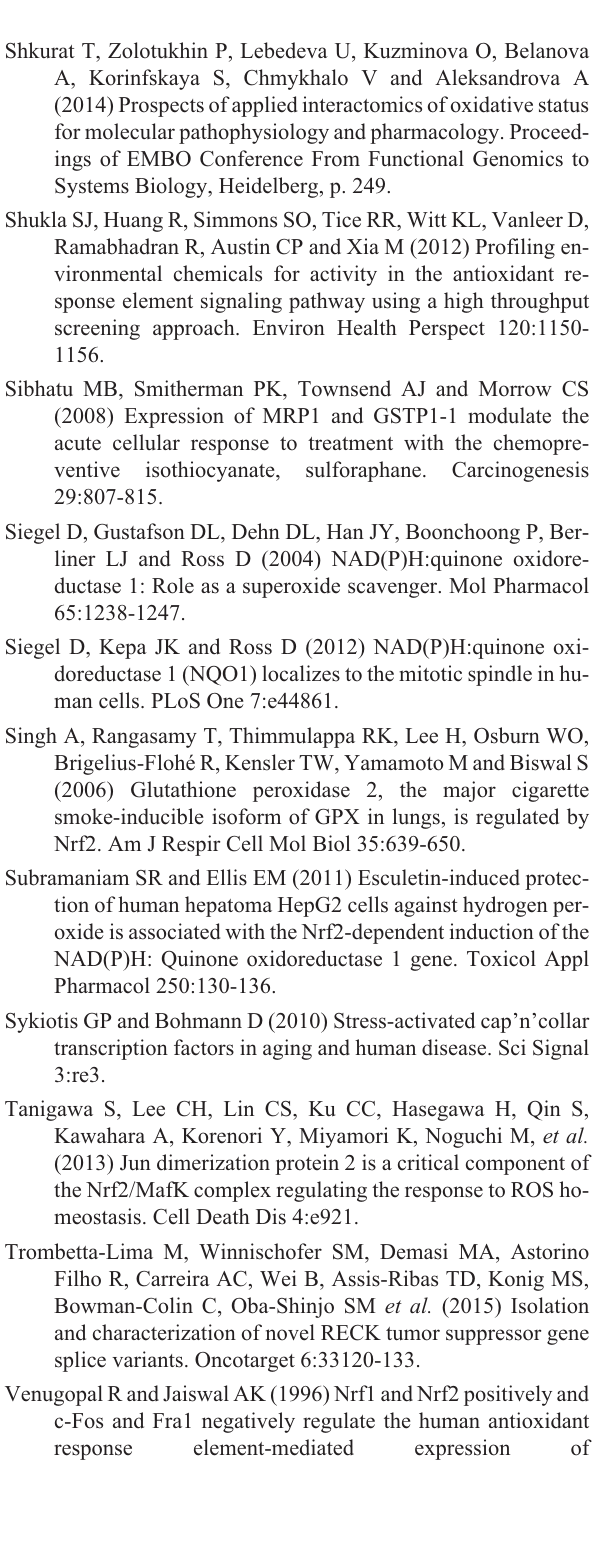
Table S1 – Primer sequences used in the